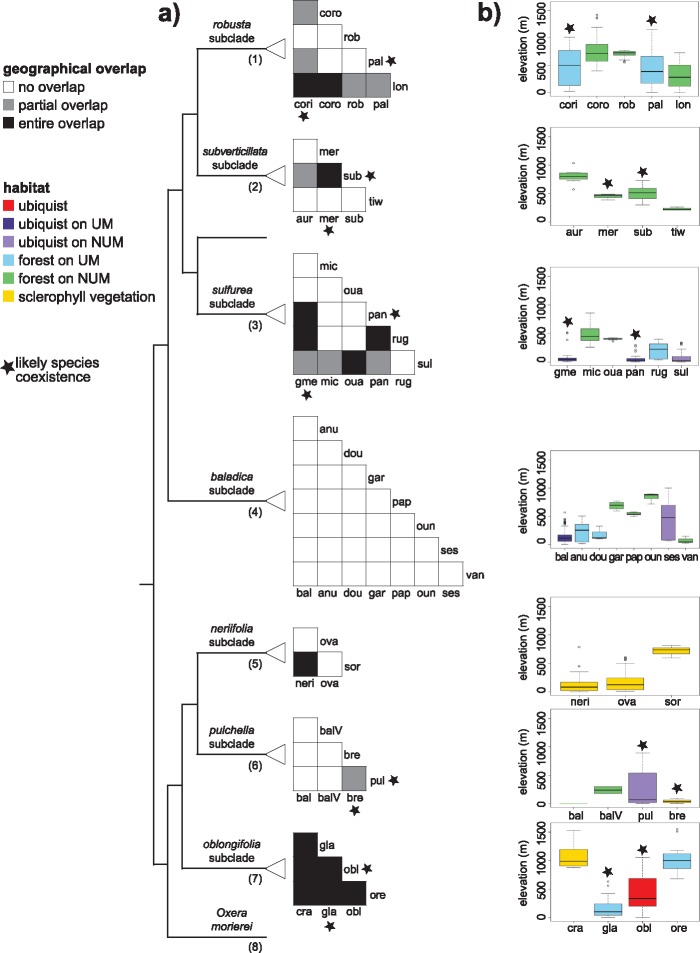
Species coexistence within Oxera, indicated by subclade, with stars indicating likely coexistence; mapped on the BEAST maximum credibility clade chronogram from the Oxera data set. a) Geographical overlap between all species of each subclade. b) Ecological ranges of all species indicated per subclade, plotted according to their altitudinal ranges and their habitat preferences (UM \documentclass[12pt]{minimal}
\usepackage{amsmath}
\usepackage{wasysym} 
\usepackage{amsfonts} 
\usepackage{amssymb} 
\usepackage{amsbsy}
\usepackage{upgreek}
\usepackage{mathrsfs}
\setlength{\oddsidemargin}{-69pt}
\begin{document}
}{}$=$\end{document} ultramafic soils, NUM \documentclass[12pt]{minimal}
\usepackage{amsmath}
\usepackage{wasysym} 
\usepackage{amsfonts} 
\usepackage{amssymb} 
\usepackage{amsbsy}
\usepackage{upgreek}
\usepackage{mathrsfs}
\setlength{\oddsidemargin}{-69pt}
\begin{document}
}{}$=$\end{document} non-ultramafic soils). Species names are indicated with the following abbreviations, listed according to subclade: robusta subclade (cori \documentclass[12pt]{minimal}
\usepackage{amsmath}
\usepackage{wasysym} 
\usepackage{amsfonts} 
\usepackage{amssymb} 
\usepackage{amsbsy}
\usepackage{upgreek}
\usepackage{mathrsfs}
\setlength{\oddsidemargin}{-69pt}
\begin{document}
}{}$=$\end{document}O. coriacea, coro \documentclass[12pt]{minimal}
\usepackage{amsmath}
\usepackage{wasysym} 
\usepackage{amsfonts} 
\usepackage{amssymb} 
\usepackage{amsbsy}
\usepackage{upgreek}
\usepackage{mathrsfs}
\setlength{\oddsidemargin}{-69pt}
\begin{document}
}{}$=$\end{document}O. coronata, lon \documentclass[12pt]{minimal}
\usepackage{amsmath}
\usepackage{wasysym} 
\usepackage{amsfonts} 
\usepackage{amssymb} 
\usepackage{amsbsy}
\usepackage{upgreek}
\usepackage{mathrsfs}
\setlength{\oddsidemargin}{-69pt}
\begin{document}
}{}$=$\end{document}O. longifolia, pal \documentclass[12pt]{minimal}
\usepackage{amsmath}
\usepackage{wasysym} 
\usepackage{amsfonts} 
\usepackage{amssymb} 
\usepackage{amsbsy}
\usepackage{upgreek}
\usepackage{mathrsfs}
\setlength{\oddsidemargin}{-69pt}
\begin{document}
}{}$=$\end{document}O. palmatinervia, rob \documentclass[12pt]{minimal}
\usepackage{amsmath}
\usepackage{wasysym} 
\usepackage{amsfonts} 
\usepackage{amssymb} 
\usepackage{amsbsy}
\usepackage{upgreek}
\usepackage{mathrsfs}
\setlength{\oddsidemargin}{-69pt}
\begin{document}
}{}$=$\end{document}O. robusta), subverticillata subclade (aur \documentclass[12pt]{minimal}
\usepackage{amsmath}
\usepackage{wasysym} 
\usepackage{amsfonts} 
\usepackage{amssymb} 
\usepackage{amsbsy}
\usepackage{upgreek}
\usepackage{mathrsfs}
\setlength{\oddsidemargin}{-69pt}
\begin{document}
}{}$=$\end{document}O. aureocalyx sp. nov. ined., mer \documentclass[12pt]{minimal}
\usepackage{amsmath}
\usepackage{wasysym} 
\usepackage{amsfonts} 
\usepackage{amssymb} 
\usepackage{amsbsy}
\usepackage{upgreek}
\usepackage{mathrsfs}
\setlength{\oddsidemargin}{-69pt}
\begin{document}
}{}$=$\end{document}O. merytifolia, sub \documentclass[12pt]{minimal}
\usepackage{amsmath}
\usepackage{wasysym} 
\usepackage{amsfonts} 
\usepackage{amssymb} 
\usepackage{amsbsy}
\usepackage{upgreek}
\usepackage{mathrsfs}
\setlength{\oddsidemargin}{-69pt}
\begin{document}
}{}$=$\end{document}O. subverticillata, tiw \documentclass[12pt]{minimal}
\usepackage{amsmath}
\usepackage{wasysym} 
\usepackage{amsfonts} 
\usepackage{amssymb} 
\usepackage{amsbsy}
\usepackage{upgreek}
\usepackage{mathrsfs}
\setlength{\oddsidemargin}{-69pt}
\begin{document}
}{}$=$\end{document}O. tiwaeana sp. nov. ined.), sulfurea subclade (gme \documentclass[12pt]{minimal}
\usepackage{amsmath}
\usepackage{wasysym} 
\usepackage{amsfonts} 
\usepackage{amssymb} 
\usepackage{amsbsy}
\usepackage{upgreek}
\usepackage{mathrsfs}
\setlength{\oddsidemargin}{-69pt}
\begin{document}
}{}$=$\end{document}O. gmelinoides, mic \documentclass[12pt]{minimal}
\usepackage{amsmath}
\usepackage{wasysym} 
\usepackage{amsfonts} 
\usepackage{amssymb} 
\usepackage{amsbsy}
\usepackage{upgreek}
\usepackage{mathrsfs}
\setlength{\oddsidemargin}{-69pt}
\begin{document}
}{}$=$\end{document}O. microcalyx, oua \documentclass[12pt]{minimal}
\usepackage{amsmath}
\usepackage{wasysym} 
\usepackage{amsfonts} 
\usepackage{amssymb} 
\usepackage{amsbsy}
\usepackage{upgreek}
\usepackage{mathrsfs}
\setlength{\oddsidemargin}{-69pt}
\begin{document}
}{}$=$\end{document}O. ouameniensis sp. nov. ined., pan \documentclass[12pt]{minimal}
\usepackage{amsmath}
\usepackage{wasysym} 
\usepackage{amsfonts} 
\usepackage{amssymb} 
\usepackage{amsbsy}
\usepackage{upgreek}
\usepackage{mathrsfs}
\setlength{\oddsidemargin}{-69pt}
\begin{document}
}{}$=$\end{document}O. pancheri, rug \documentclass[12pt]{minimal}
\usepackage{amsmath}
\usepackage{wasysym} 
\usepackage{amsfonts} 
\usepackage{amssymb} 
\usepackage{amsbsy}
\usepackage{upgreek}
\usepackage{mathrsfs}
\setlength{\oddsidemargin}{-69pt}
\begin{document}
}{}$=$\end{document}O. rugosa, sul \documentclass[12pt]{minimal}
\usepackage{amsmath}
\usepackage{wasysym} 
\usepackage{amsfonts} 
\usepackage{amssymb} 
\usepackage{amsbsy}
\usepackage{upgreek}
\usepackage{mathrsfs}
\setlength{\oddsidemargin}{-69pt}
\begin{document}
}{}$=$\end{document}O. sulfurea), baladica subclade (bal \documentclass[12pt]{minimal}
\usepackage{amsmath}
\usepackage{wasysym} 
\usepackage{amsfonts} 
\usepackage{amssymb} 
\usepackage{amsbsy}
\usepackage{upgreek}
\usepackage{mathrsfs}
\setlength{\oddsidemargin}{-69pt}
\begin{document}
}{}$=$\end{document}O. baladica, anu \documentclass[12pt]{minimal}
\usepackage{amsmath}
\usepackage{wasysym} 
\usepackage{amsfonts} 
\usepackage{amssymb} 
\usepackage{amsbsy}
\usepackage{upgreek}
\usepackage{mathrsfs}
\setlength{\oddsidemargin}{-69pt}
\begin{document}
}{}$=$\end{document}\documentclass[12pt]{minimal}
\usepackage{amsmath}
\usepackage{wasysym} 
\usepackage{amsfonts} 
\usepackage{amssymb} 
\usepackage{amsbsy}
\usepackage{upgreek}
\usepackage{mathrsfs}
\setlength{\oddsidemargin}{-69pt}
\begin{document}
}{}$O$\end{document}. aff. nuda, dou \documentclass[12pt]{minimal}
\usepackage{amsmath}
\usepackage{wasysym} 
\usepackage{amsfonts} 
\usepackage{amssymb} 
\usepackage{amsbsy}
\usepackage{upgreek}
\usepackage{mathrsfs}
\setlength{\oddsidemargin}{-69pt}
\begin{document}
}{}$=$\end{document}O. doubetiae sp. nov. ined., gar \documentclass[12pt]{minimal}
\usepackage{amsmath}
\usepackage{wasysym} 
\usepackage{amsfonts} 
\usepackage{amssymb} 
\usepackage{amsbsy}
\usepackage{upgreek}
\usepackage{mathrsfs}
\setlength{\oddsidemargin}{-69pt}
\begin{document}
}{}$=$\end{document}O. garoensis sp. nov. ined., oun \documentclass[12pt]{minimal}
\usepackage{amsmath}
\usepackage{wasysym} 
\usepackage{amsfonts} 
\usepackage{amssymb} 
\usepackage{amsbsy}
\usepackage{upgreek}
\usepackage{mathrsfs}
\setlength{\oddsidemargin}{-69pt}
\begin{document}
}{}$=$\end{document}O. ounemoae sp. nov. ined., pap \documentclass[12pt]{minimal}
\usepackage{amsmath}
\usepackage{wasysym} 
\usepackage{amsfonts} 
\usepackage{amssymb} 
\usepackage{amsbsy}
\usepackage{upgreek}
\usepackage{mathrsfs}
\setlength{\oddsidemargin}{-69pt}
\begin{document}
}{}$=$\end{document}O. papineaui sp. nov. ined., ses \documentclass[12pt]{minimal}
\usepackage{amsmath}
\usepackage{wasysym} 
\usepackage{amsfonts} 
\usepackage{amssymb} 
\usepackage{amsbsy}
\usepackage{upgreek}
\usepackage{mathrsfs}
\setlength{\oddsidemargin}{-69pt}
\begin{document}
}{}$=$\end{document}O. sessilifolia, van \documentclass[12pt]{minimal}
\usepackage{amsmath}
\usepackage{wasysym} 
\usepackage{amsfonts} 
\usepackage{amssymb} 
\usepackage{amsbsy}
\usepackage{upgreek}
\usepackage{mathrsfs}
\setlength{\oddsidemargin}{-69pt}
\begin{document}
}{}$=$\end{document}O. vanuatuensis), neriifolia subclade (neri \documentclass[12pt]{minimal}
\usepackage{amsmath}
\usepackage{wasysym} 
\usepackage{amsfonts} 
\usepackage{amssymb} 
\usepackage{amsbsy}
\usepackage{upgreek}
\usepackage{mathrsfs}
\setlength{\oddsidemargin}{-69pt}
\begin{document}
}{}$=$\end{document}O. neriifolia, ova \documentclass[12pt]{minimal}
\usepackage{amsmath}
\usepackage{wasysym} 
\usepackage{amsfonts} 
\usepackage{amssymb} 
\usepackage{amsbsy}
\usepackage{upgreek}
\usepackage{mathrsfs}
\setlength{\oddsidemargin}{-69pt}
\begin{document}
}{}$=$\end{document}O. ovata, sor \documentclass[12pt]{minimal}
\usepackage{amsmath}
\usepackage{wasysym} 
\usepackage{amsfonts} 
\usepackage{amssymb} 
\usepackage{amsbsy}
\usepackage{upgreek}
\usepackage{mathrsfs}
\setlength{\oddsidemargin}{-69pt}
\begin{document}
}{}$=$\end{document}O. sororia), pulchella subclade (bal \documentclass[12pt]{minimal}
\usepackage{amsmath}
\usepackage{wasysym} 
\usepackage{amsfonts} 
\usepackage{amssymb} 
\usepackage{amsbsy}
\usepackage{upgreek}
\usepackage{mathrsfs}
\setlength{\oddsidemargin}{-69pt}
\begin{document}
}{}$=$\end{document}O. balansae, balV \documentclass[12pt]{minimal}
\usepackage{amsmath}
\usepackage{wasysym} 
\usepackage{amsfonts} 
\usepackage{amssymb} 
\usepackage{amsbsy}
\usepackage{upgreek}
\usepackage{mathrsfs}
\setlength{\oddsidemargin}{-69pt}
\begin{document}
}{}$=$\end{document}\documentclass[12pt]{minimal}
\usepackage{amsmath}
\usepackage{wasysym} 
\usepackage{amsfonts} 
\usepackage{amssymb} 
\usepackage{amsbsy}
\usepackage{upgreek}
\usepackage{mathrsfs}
\setlength{\oddsidemargin}{-69pt}
\begin{document}
}{}$O.$\end{document}aff. balansae, bre \documentclass[12pt]{minimal}
\usepackage{amsmath}
\usepackage{wasysym} 
\usepackage{amsfonts} 
\usepackage{amssymb} 
\usepackage{amsbsy}
\usepackage{upgreek}
\usepackage{mathrsfs}
\setlength{\oddsidemargin}{-69pt}
\begin{document}
}{}$=$\end{document}O. brevicalyx, pul \documentclass[12pt]{minimal}
\usepackage{amsmath}
\usepackage{wasysym} 
\usepackage{amsfonts} 
\usepackage{amssymb} 
\usepackage{amsbsy}
\usepackage{upgreek}
\usepackage{mathrsfs}
\setlength{\oddsidemargin}{-69pt}
\begin{document}
}{}$=$\end{document}O. pulchella), and oblongifolia subclade (cra \documentclass[12pt]{minimal}
\usepackage{amsmath}
\usepackage{wasysym} 
\usepackage{amsfonts} 
\usepackage{amssymb} 
\usepackage{amsbsy}
\usepackage{upgreek}
\usepackage{mathrsfs}
\setlength{\oddsidemargin}{-69pt}
\begin{document}
}{}$=$\end{document}O. crassifolia, gla \documentclass[12pt]{minimal}
\usepackage{amsmath}
\usepackage{wasysym} 
\usepackage{amsfonts} 
\usepackage{amssymb} 
\usepackage{amsbsy}
\usepackage{upgreek}
\usepackage{mathrsfs}
\setlength{\oddsidemargin}{-69pt}
\begin{document}
}{}$=$\end{document}O. glandulosa, obl \documentclass[12pt]{minimal}
\usepackage{amsmath}
\usepackage{wasysym} 
\usepackage{amsfonts} 
\usepackage{amssymb} 
\usepackage{amsbsy}
\usepackage{upgreek}
\usepackage{mathrsfs}
\setlength{\oddsidemargin}{-69pt}
\begin{document}
}{}$=$\end{document}O. oblongifolia, ore \documentclass[12pt]{minimal}
\usepackage{amsmath}
\usepackage{wasysym} 
\usepackage{amsfonts} 
\usepackage{amssymb} 
\usepackage{amsbsy}
\usepackage{upgreek}
\usepackage{mathrsfs}
\setlength{\oddsidemargin}{-69pt}
\begin{document}
}{}$=$\end{document}O. oreophila).